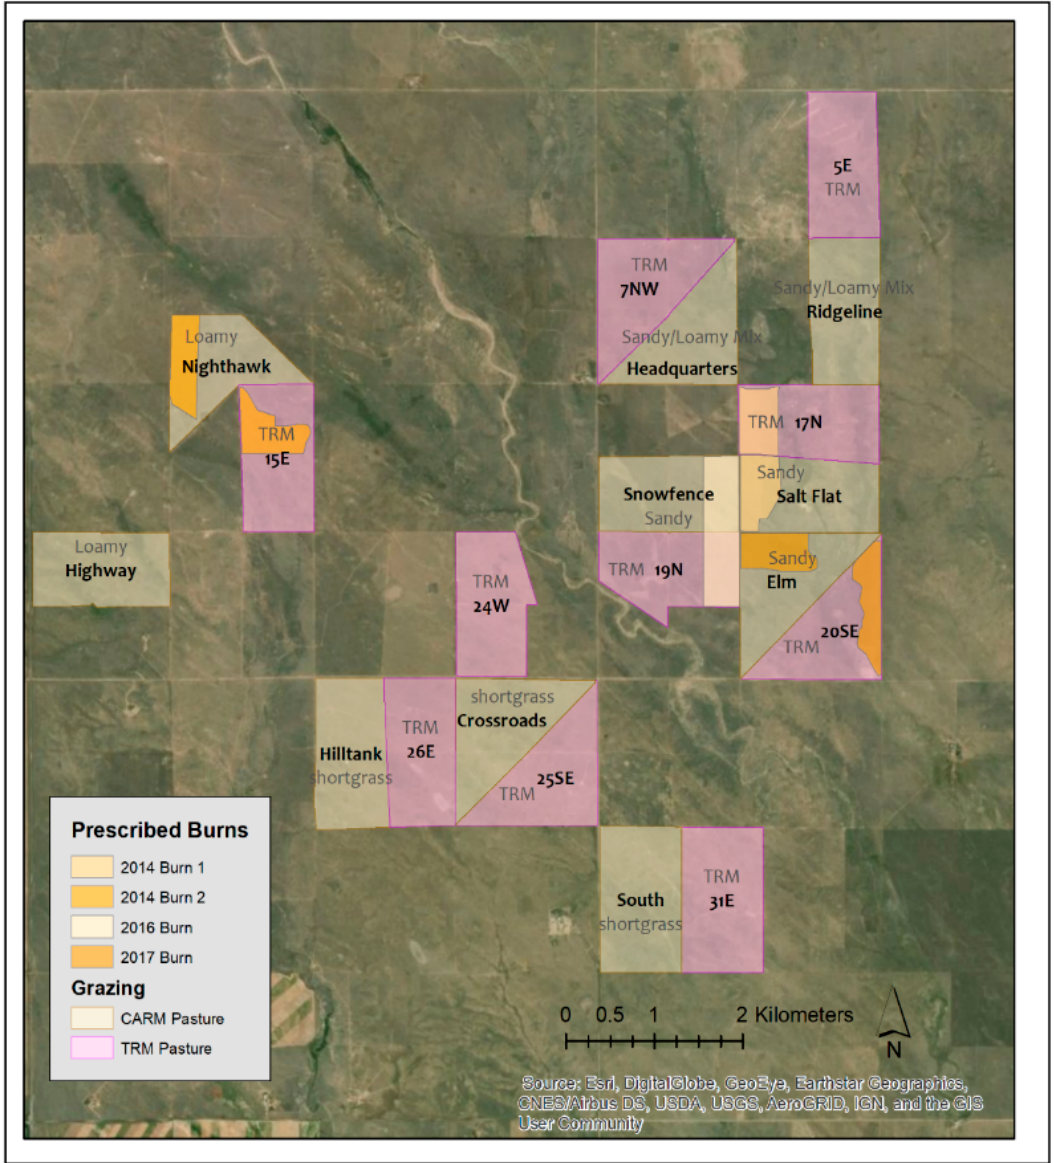
Figure 2. The CARM project includes ten, 130 ha named pastures managed by a team of local ranchers, conservation organization representatives, public agency employees, and interdisciplinary